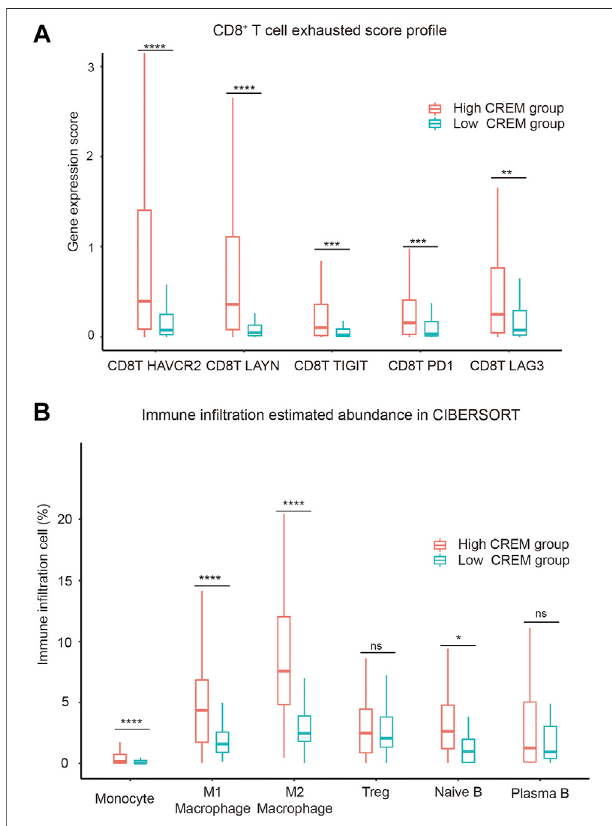
FIGURE 4 | Correlation between CREM expression and immune- suppressive microenvironment. (A) CD8 + T-cell exhausted score pro fi le between the high CREM group and low CREM group. (B) The immune in fi ltration estimated abundance in CIBERSORT; the estimated abundance is absolute type in CIBERSORT